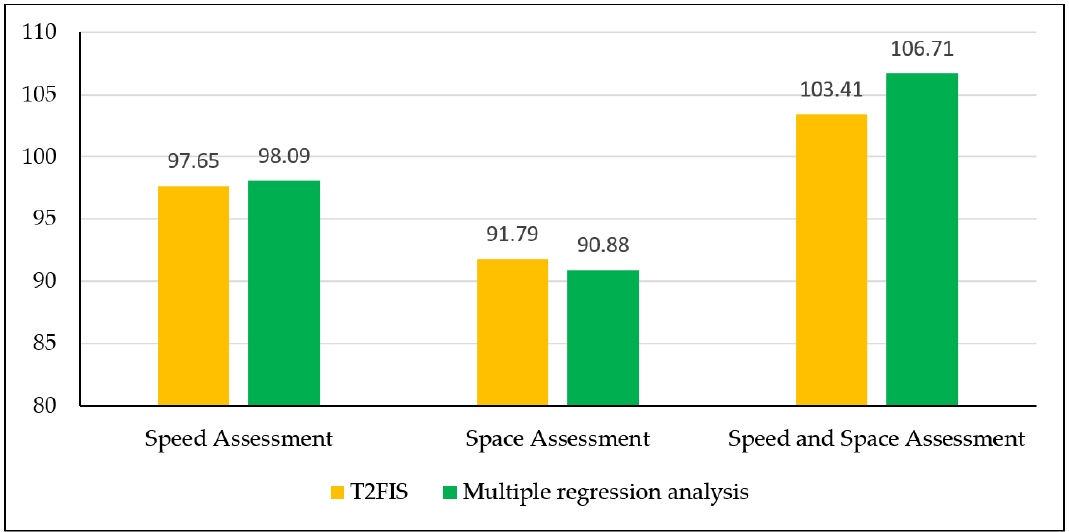
Figure 14. A comparison of T2FIS performance and multiple regression analysis.